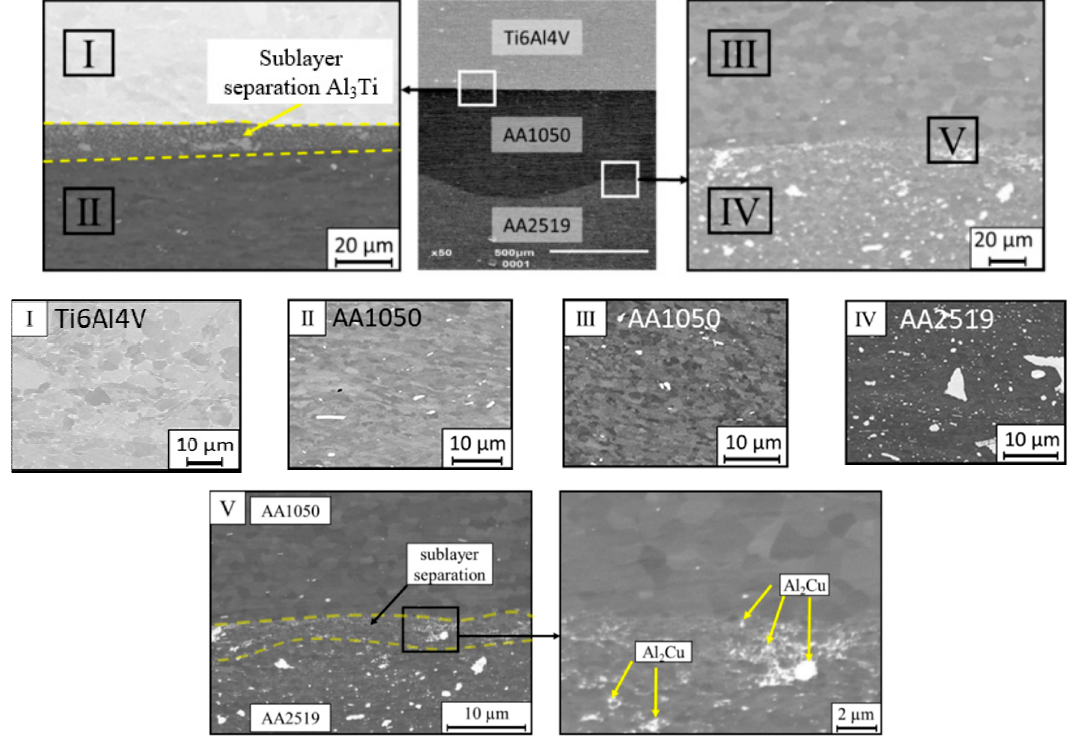
Figure2. Metallographiccross-sectionsobtainedwithscanningelectronmicroscopyofthemanufactured Figure 2. Metallographic cross-sections obtained with scanning electron microscopy of the laminate AA2519-AA1050-Ti6Al4V. manufactured laminate AA2519-AA1050-Ti6Al4V.